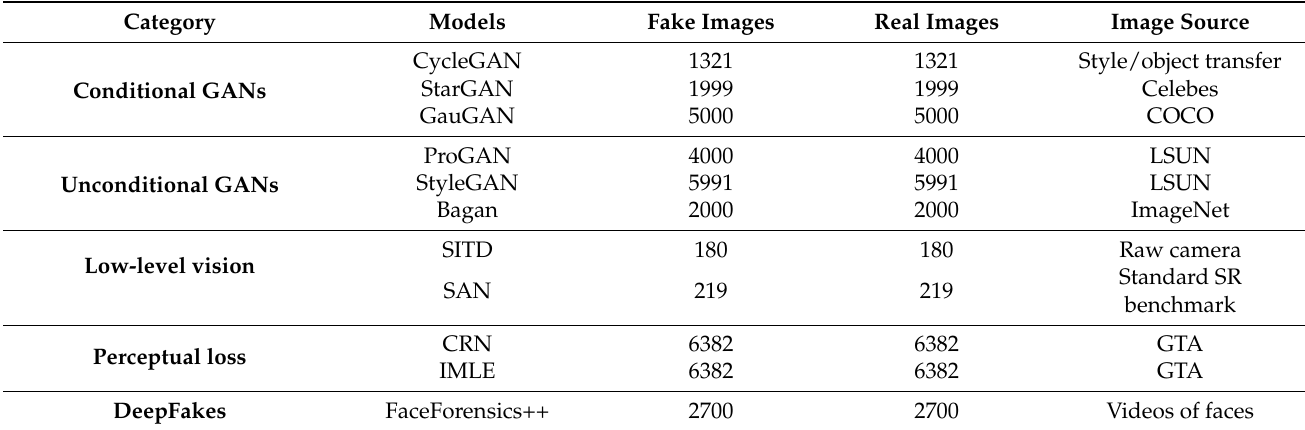
Table 1. Generation Models